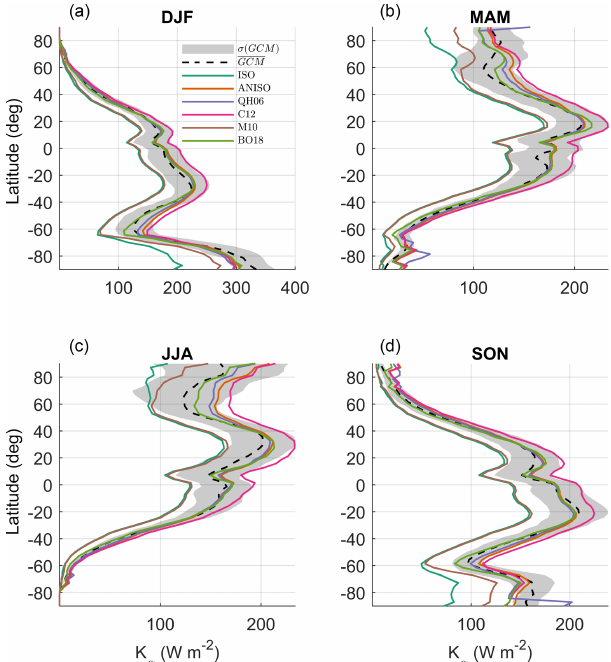
Figure 1. Latitudinal (1 ◦ ) and seasonal means of the multi-GCM mean ( K GCM